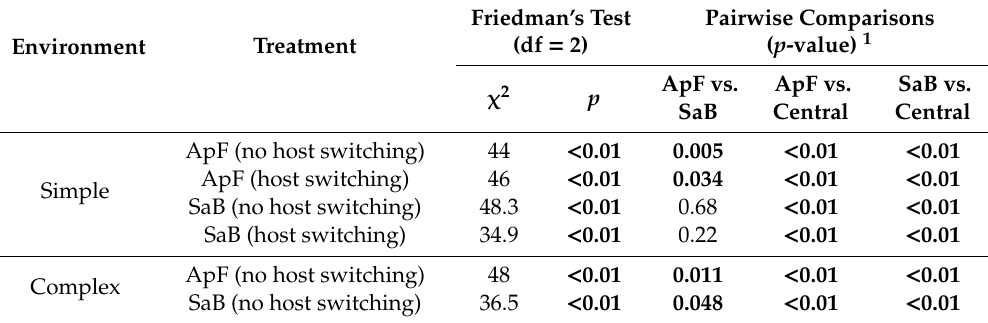
Figure 2. Time spent in the di ff erent branches of the olfactometer by Aphidius ervi females reared in simple environments. Females were reared on their respective HPC ( Acyrthosiphon pisum / faba bean = ApF or Sitobion avenae / barley = SaB) ( A , B ) for several generations, ( C , D ) for one generation (host switch). Boxplot boundaries indicate the first and third quartiles and black lines within plots indicate the median for each treatment. Whiskers length equal to 1.5 × interquartile range, other points are outliers. Bars with the same lower-case letters indicate no significant di ff erences (Wilcoxon test). Table 1. Summary statistics for the behavioral experiments.